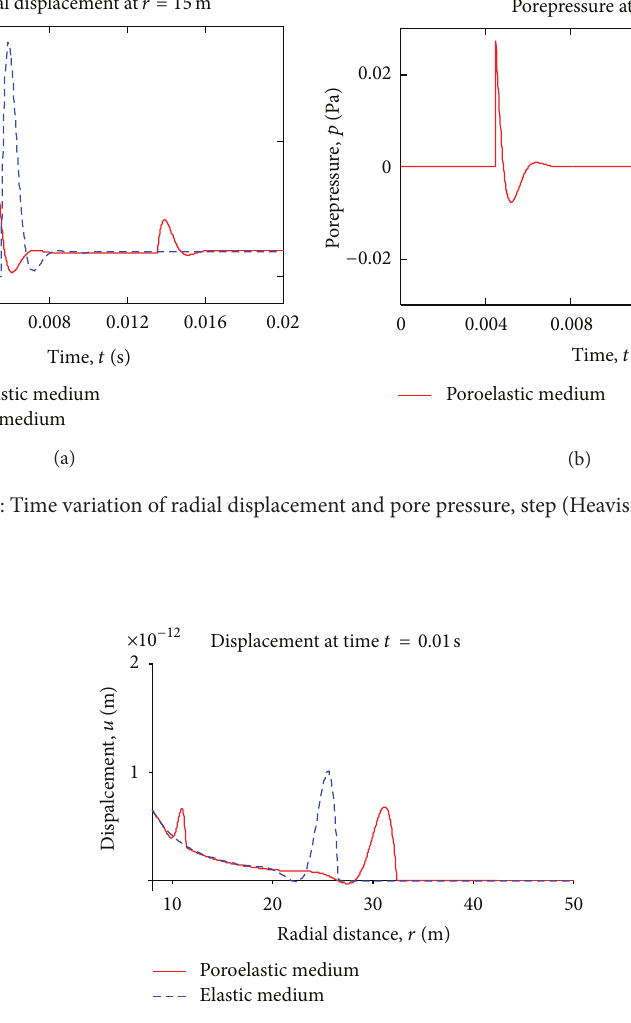
Figure 6: Displacement wave in the media at a particular time, step (Heaviside) pulse case.